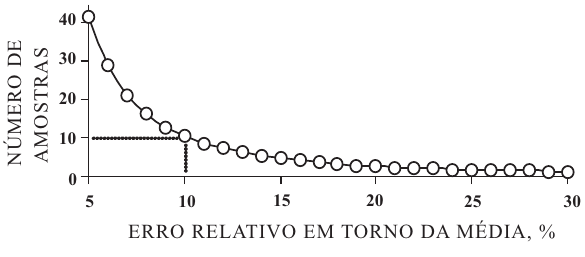
Figura 2. Número necessário de amostras para estimativa da média da σσσσσ relativo em torno da média, em nível de significância de 5